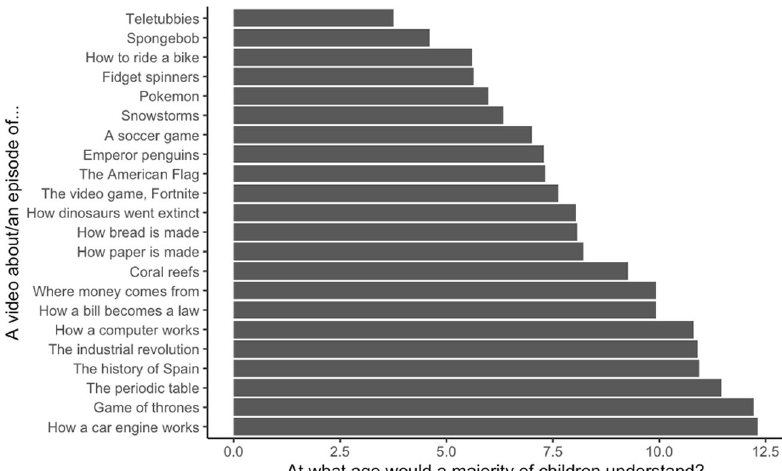
Fig. 1 Adults ’ average age of understanding judgements. Bars depict adults ’ mean ratings at which age a majority of children would understand a video about a variety of